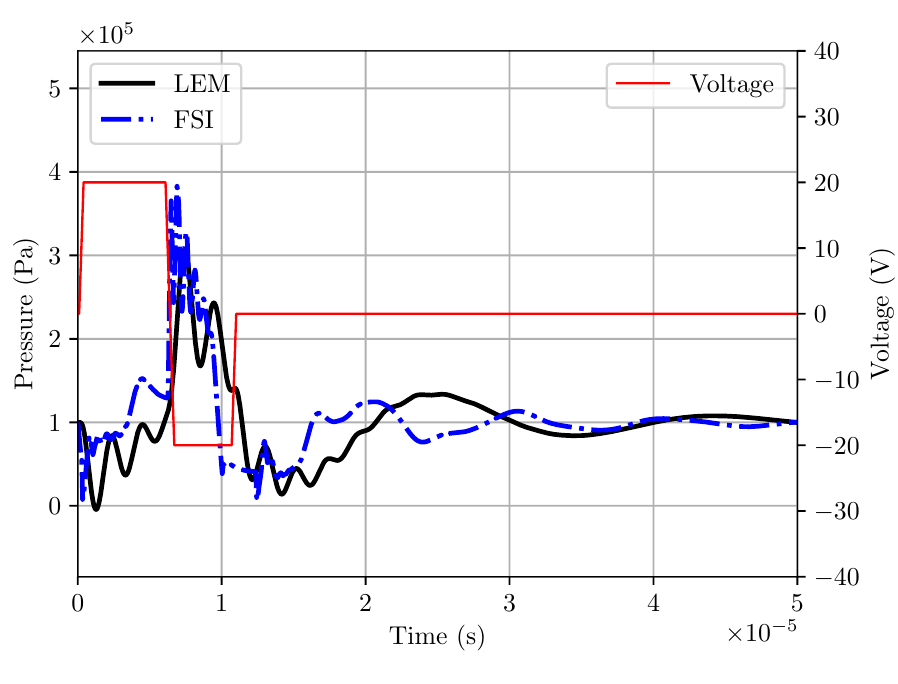
Figure 13. Comparison of pressure obtained from LEM with a 3D fluid–structure interaction model for RC1536